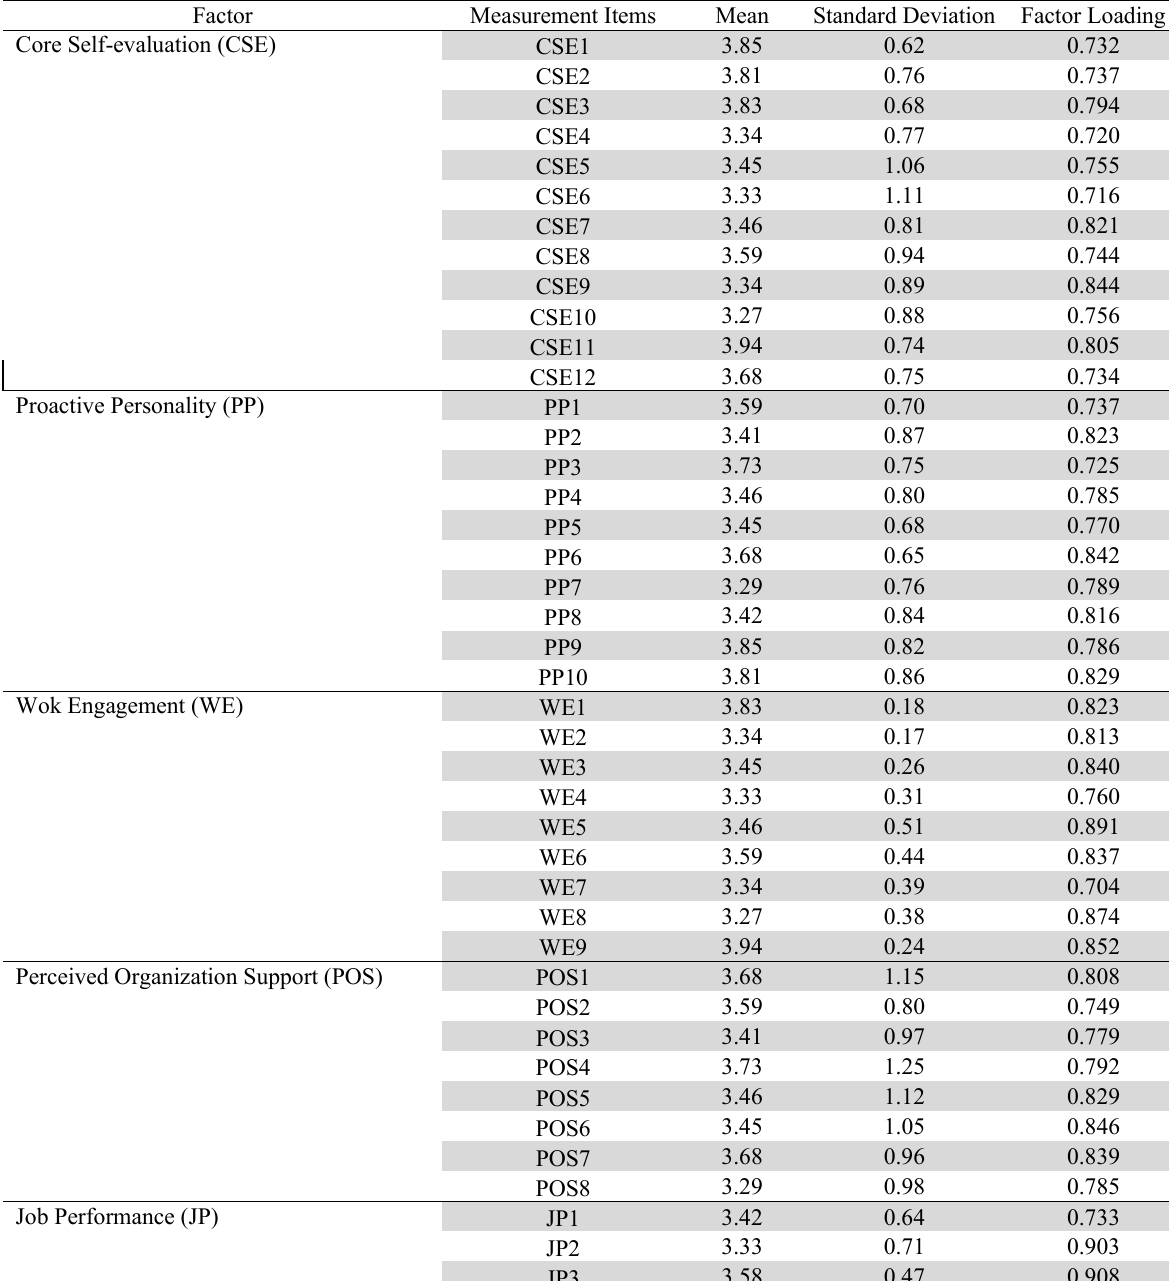
Measurement Model Evaluation Result Factor Measurement Items Mean Standard Deviation Core Self-evaluation